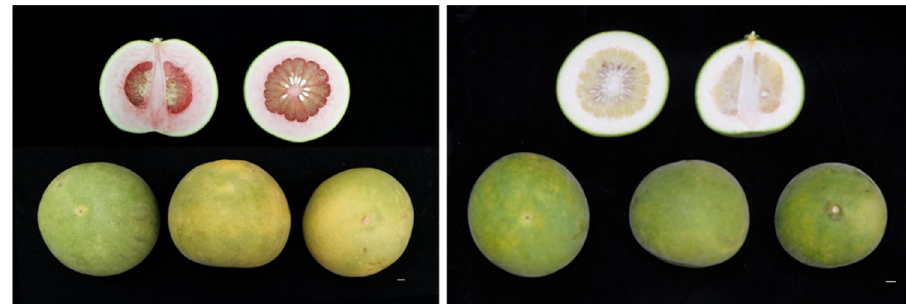
Figure 1. Internal appearance of red-fleshed pummelo ( left ) and wild-type HJH pummelo ( right ) fruit.